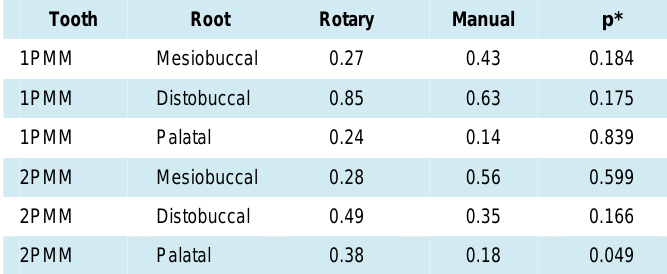
Table 2: Analysis of apical displacement (in millimeters) comparing the tech- niques used (rotary vs. manual instrumentation).